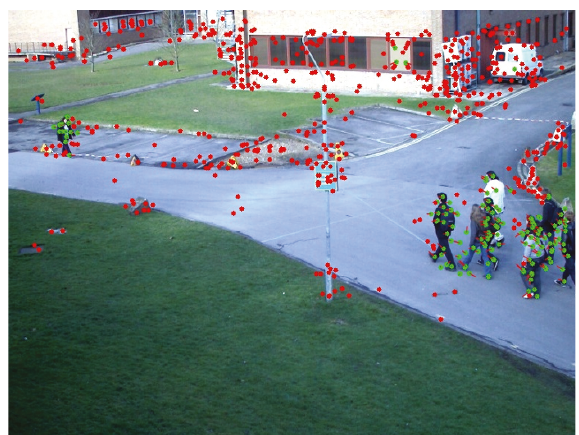
Figure 2: The interest points detected by the SURF algorithm, together with the corresponding motion vectors. The static points are drawn in red, the moving ones in